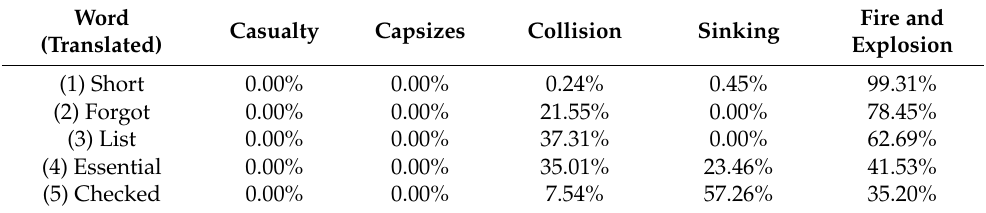
Table 8. Latent-cause words in complex collision accidents in the category of “fire